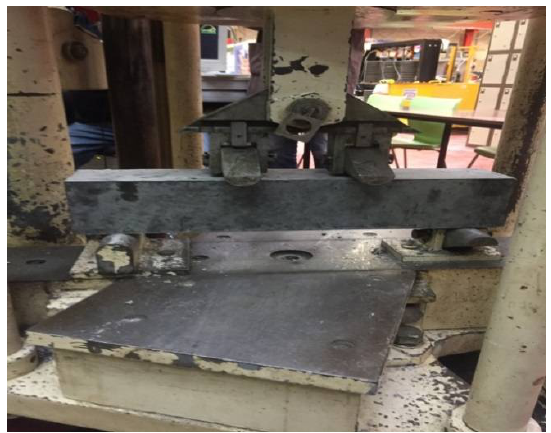
Figure 10. 4-point bending test.